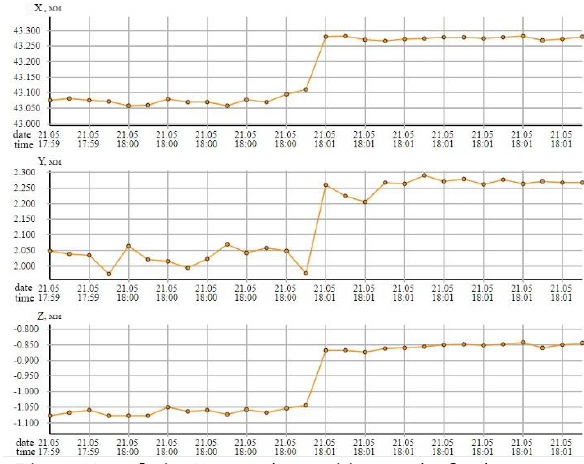
again. The graphs of the right block of marks center position on three coordinate axes in the coordinate system of the left block of marks are shown in Fig.13.